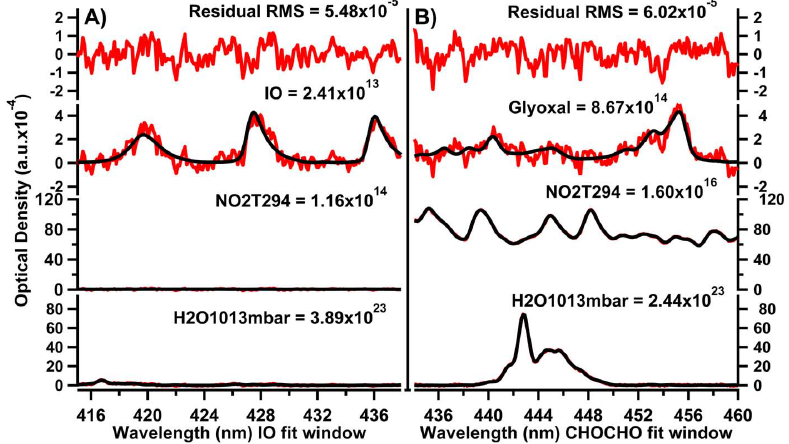
Fig. 8. Spectral proof for the detection of IO and CHOCHO. Spectra were analyzed for IO in the 415–438nm range, while the range of 434–460nm was used for CHOCHO. (A) : the IO fit is from 3 April 2010 at 18:42UTC in the 179.2 ◦ viewing angle, and (B) : the CHOCHO fit is from 23 March 2010 at 19:23UTC in the 3.8 ◦ viewing